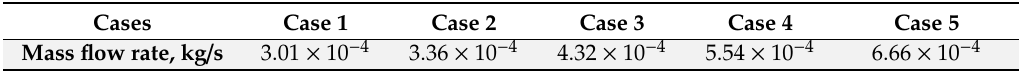
Table 2. Collector inlet mass flow rates for di ff erent